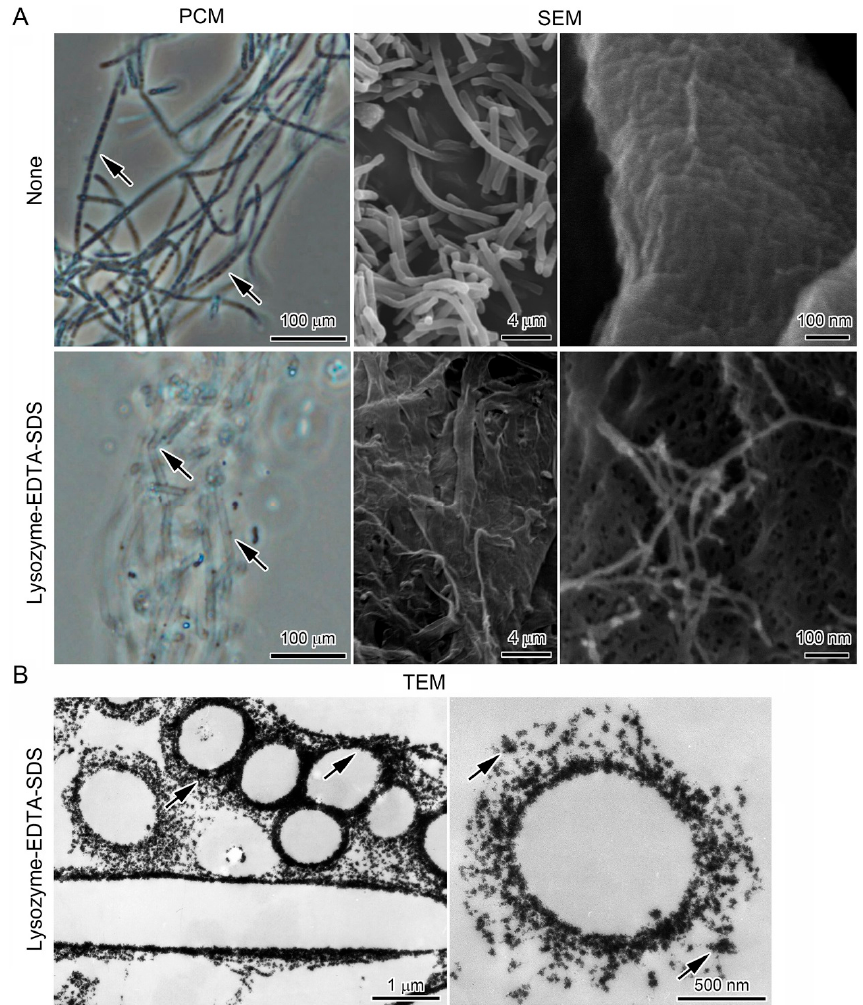
Figure 5. Adherence of electron-dense particles onto LES-treated sheath remnants. ( A ) PCM and SEM images of LES-treated sheaths ( lower ) and untreated sheaths ( upper ). Note that the treatment successfully released nano-scaled fibrils from sheaths ( lower right ); ( B ) TEM images of LES-treated sheaths after 14 days incubation in SGP + Fe. Note that the treatment successfully removed cells, leaving the sheath remnants. Arrows indicate electron-dense particles that correspond to Fe(III) abiotically generated in the medium.